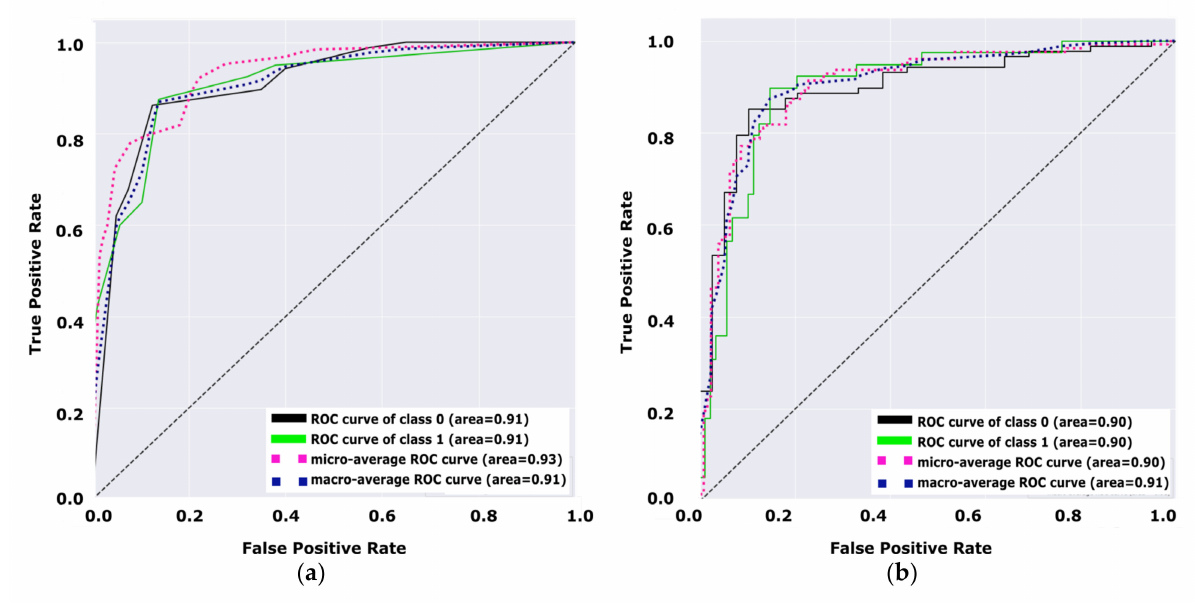
Figure 8. ( a ) ROC curve of the DT classifier for PIDD and ( b ) ROC curve of the NB classifier for PIDD.